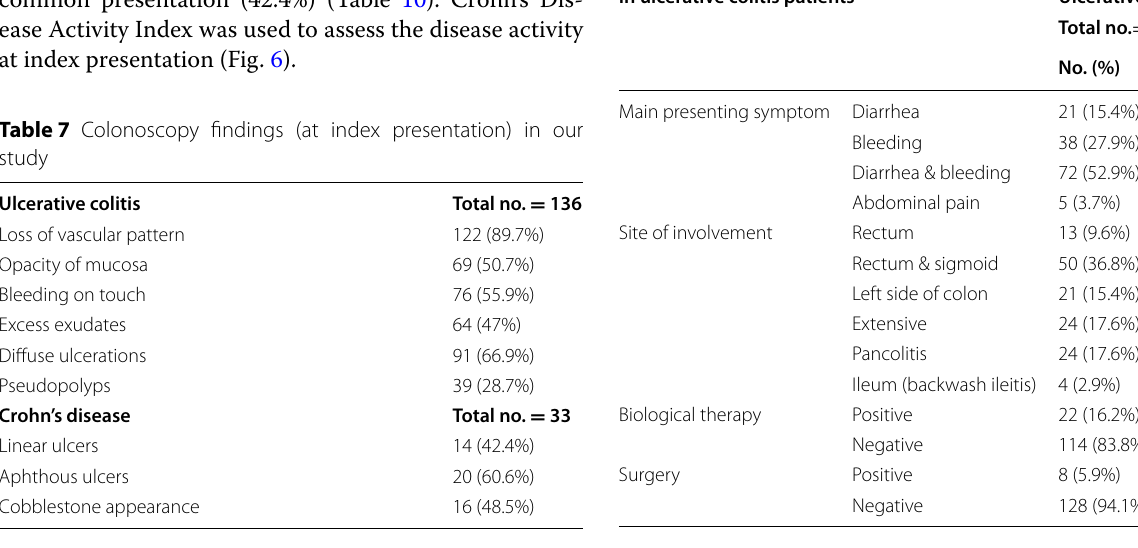
(Table 9). The activity of the disease at index presentation was evaluated by Truelove & Witts criteria and by Mayo score (Figs. 4 and 5).